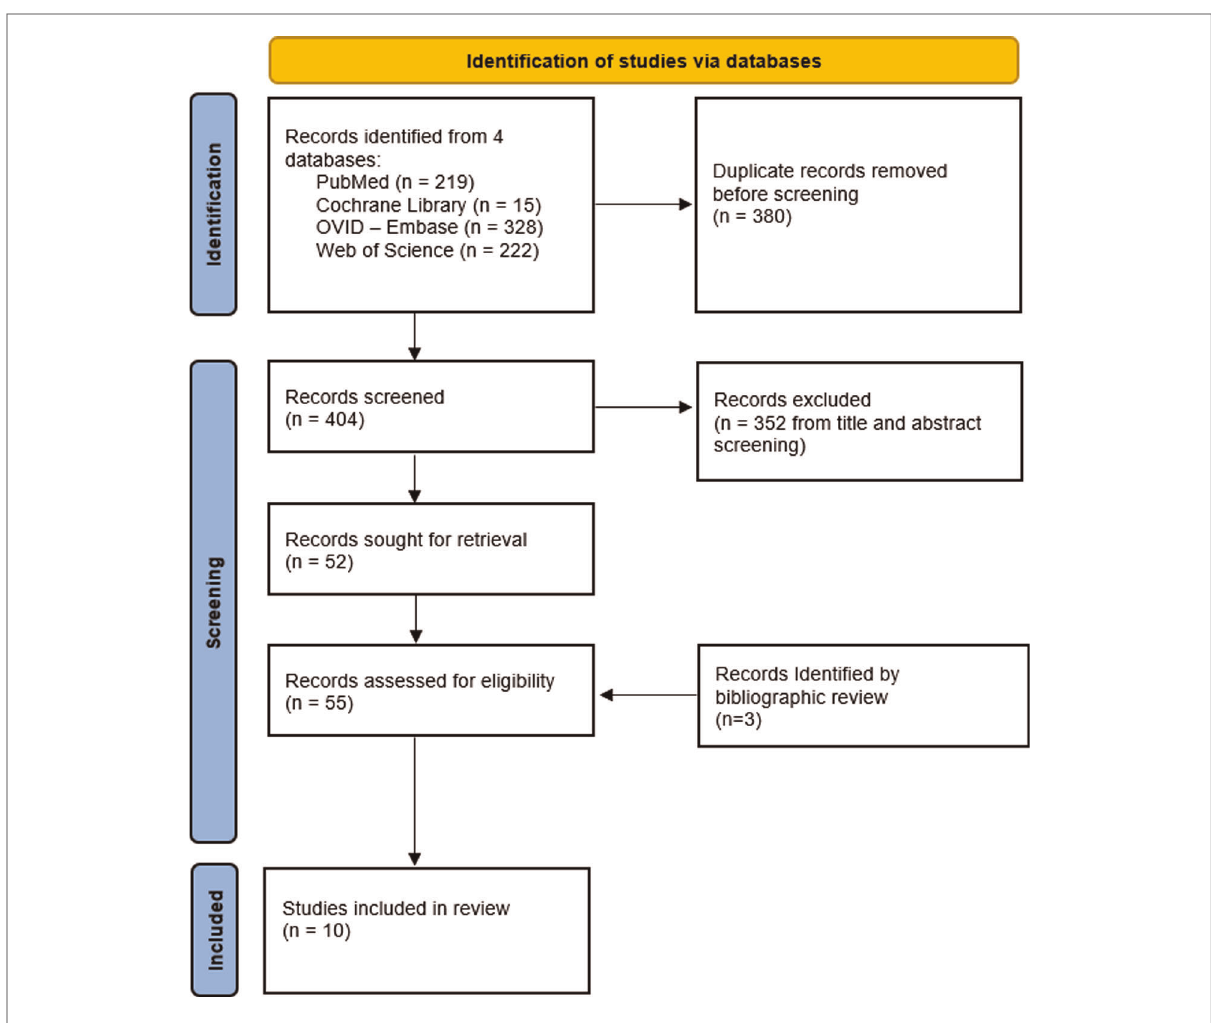
FIGURE 1 PRISMA-Style fl ow diagram of study retrieval and